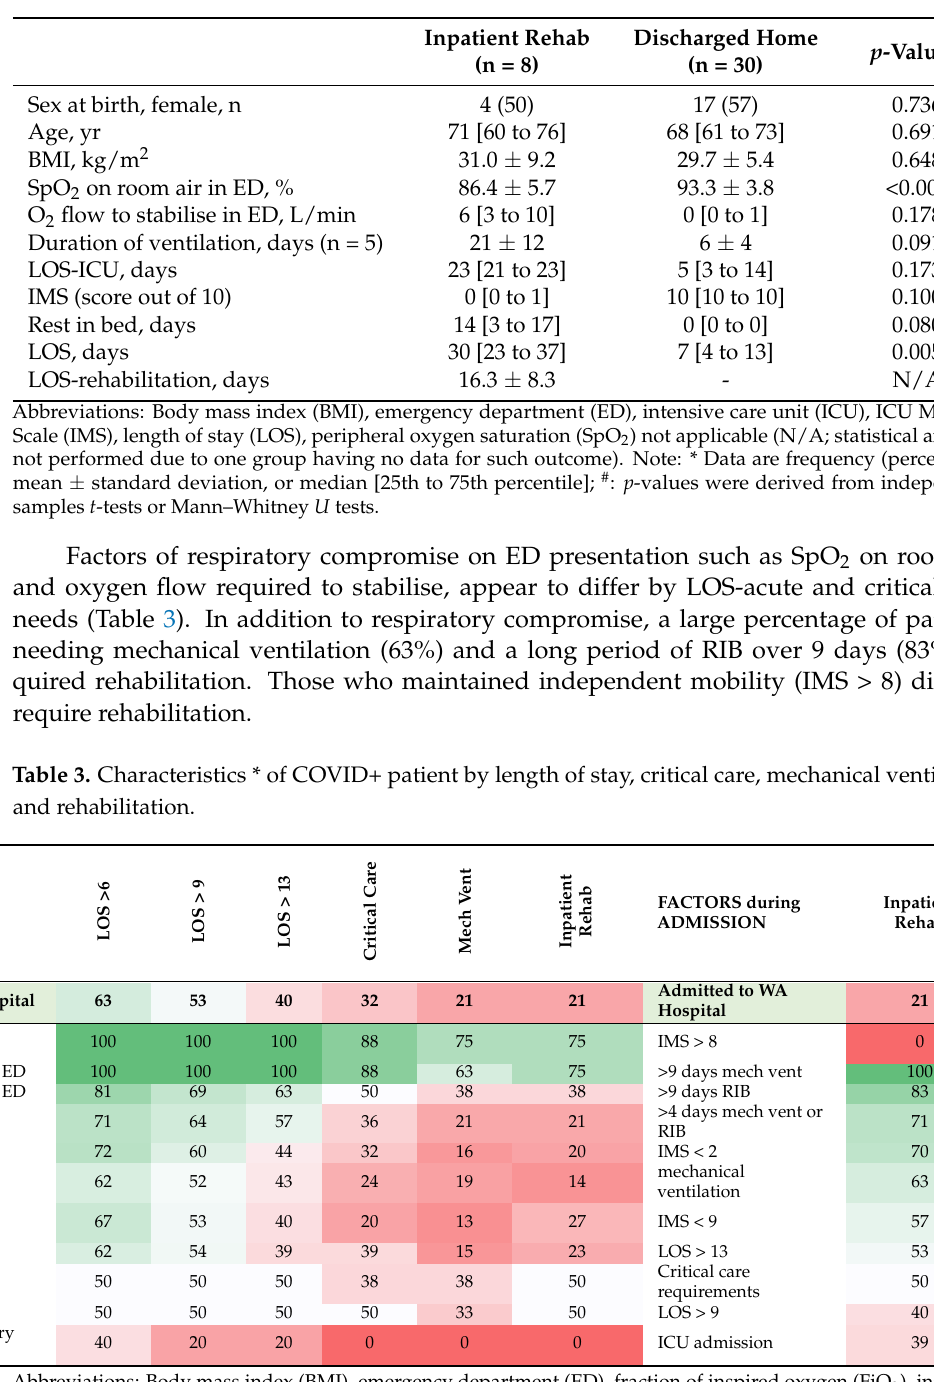
Table 2. Comparison of COVID+ participants * grouped according to their discharge destination.